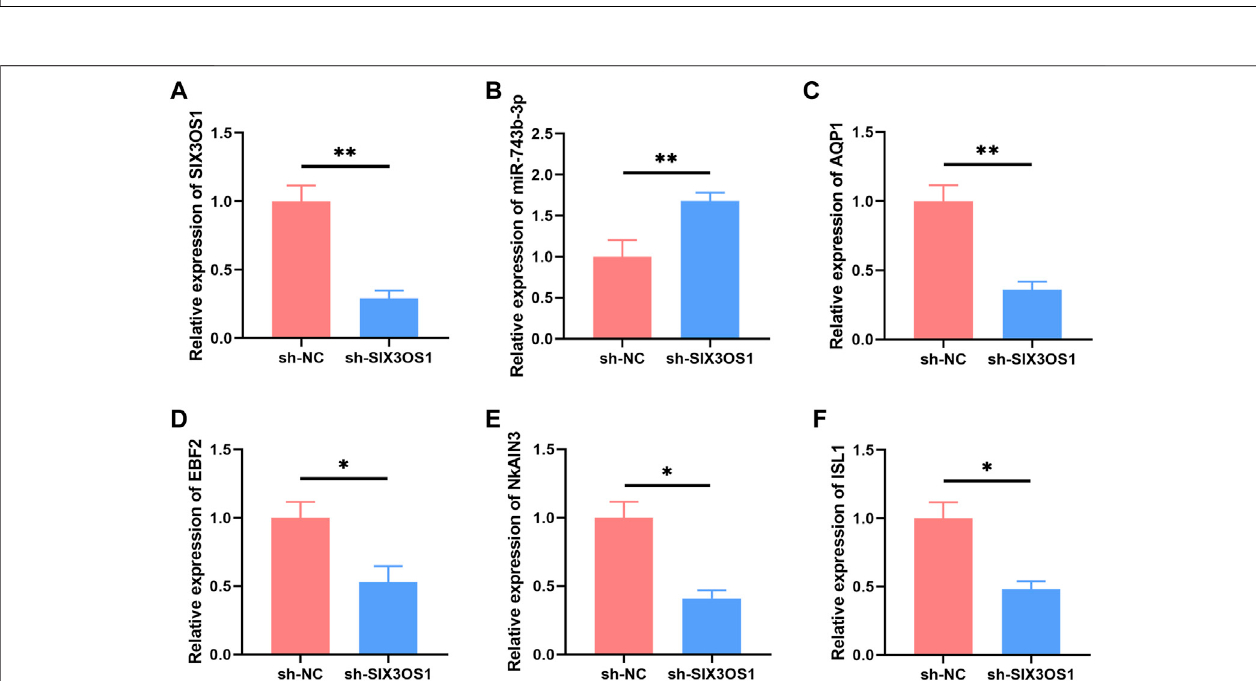
FIGURE 8 | SIX3OS1 regulates the expression of miR-743b-3p, AQP1, EBF2, NKAIN3 and ISL1 in HE mice. (A) qRT-PCR con fi rmed that SIX3OS1-shRNA lentiviruses inhibited the expression of SIX3OS1. Silencing SIX3OS1 induces miR-743b-3p upregulate (B) , while AQP1 (C) , EBF2 (D) , NKAIN3 (E) , and ISL1 (F) downregulate. GAPDH was used as an internal control. Error bars: standard deviation ( n = 3). qRT-PCR, quantitative reverse transcription-polymerase chain reaction. * p < 0.05, ** p < 0.01.